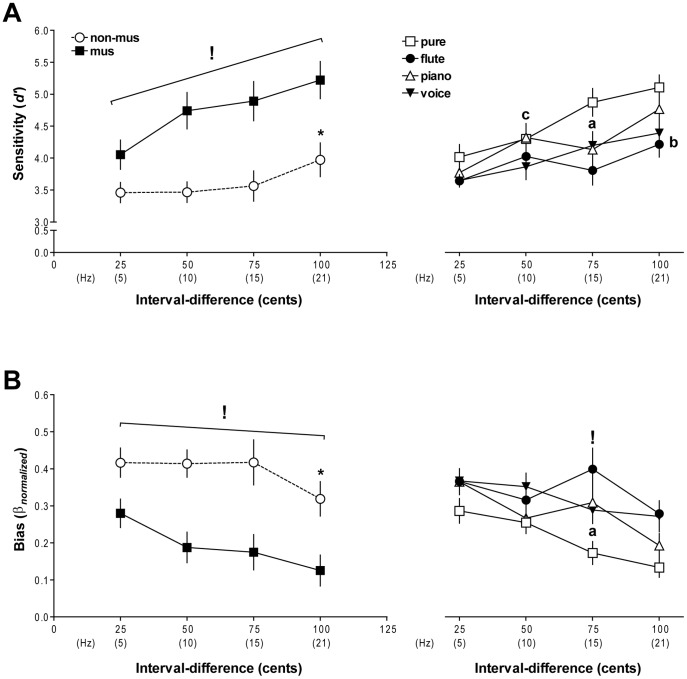
Interval-discrimination sensitivity and response bias.(A) Left: Mean ± SEM d′ values of musicians and non-musicians across all timbres at each interval-difference. Musicians exhibited more discrimination sensitivity across all interval-differences, compared to non-musicians (denoted by!, p<0.01). Across interval-differences, on-musicians only showed enhanced discrimination sensitivity at a difference of 100 cents (marked by *, p<0.01). Right: Mean ± SEM d′ values for each timbre at each interval-difference, averaged across both groups. Listeners exhibited enhanced discrimination sensitivity at interval-differences of 75 cents with pure and voice tones (indicated with a, ps<0.05), 100 cents with flute tones (marked with b, p<0.001), and 50 cents with a piano timbre (denoted by c, p<0.06). (B) Left: Mean ± SEM βnormalized values (measure of response bias) for musicians and non-musicians at each interval-difference, collapsed across all timbre types. In general, non-musicians showed greater bias towards selecting the second interval as the larger interval than non-musicians (shown with!, p<0.01), and this bias only significantly decreased within the group at the 100-cent interval-difference (indicated by *, p<0.001). Right: Mean ± SEM βnormalized values for each timbre at all interval-differences, averaged across both groups. Response bias decreased significantly with pure and voice-tones at 75 cents (marked by a, ps<0.05). Interestingly, response bias was highest at a 75-cent interval-difference with flute tones, compared to all other timbres (shown by!, p<0.05).